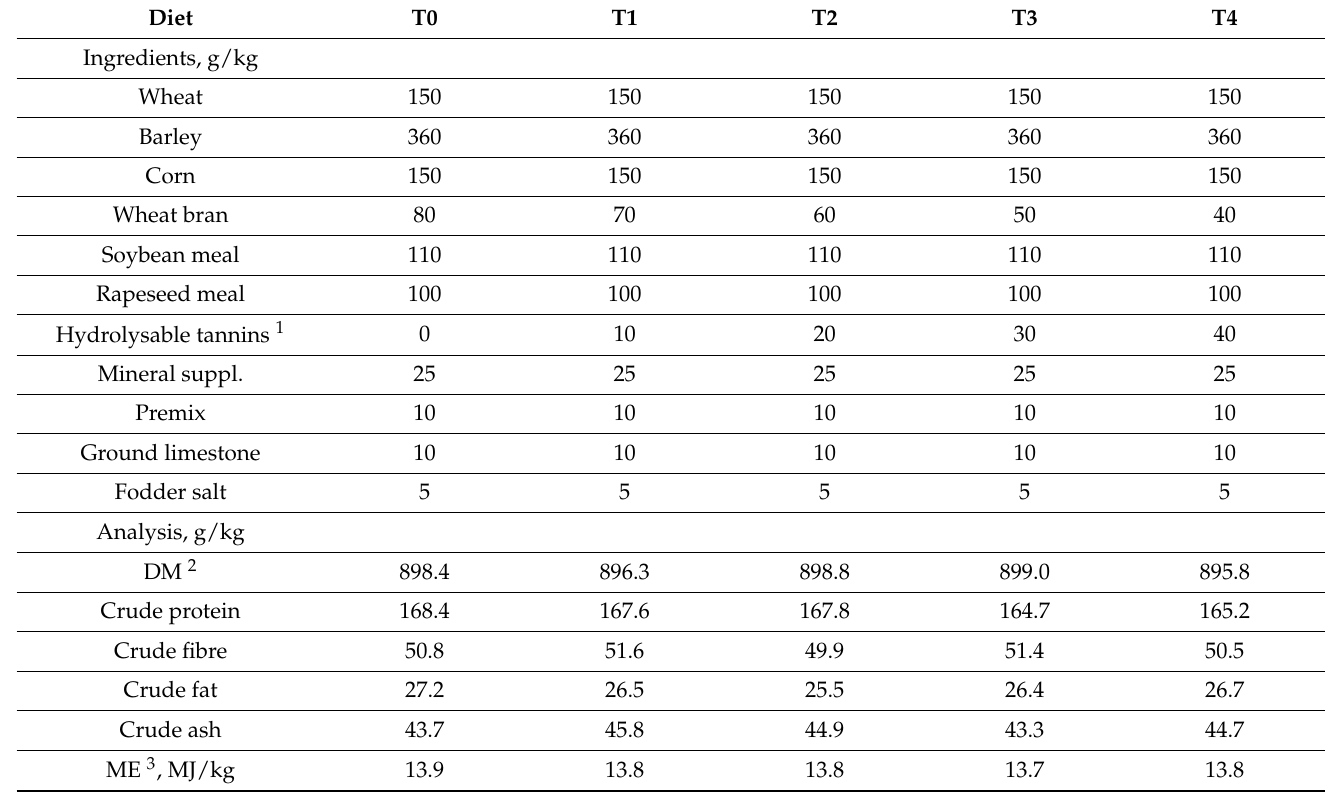
Table 1. Ingredients and chemical composition of